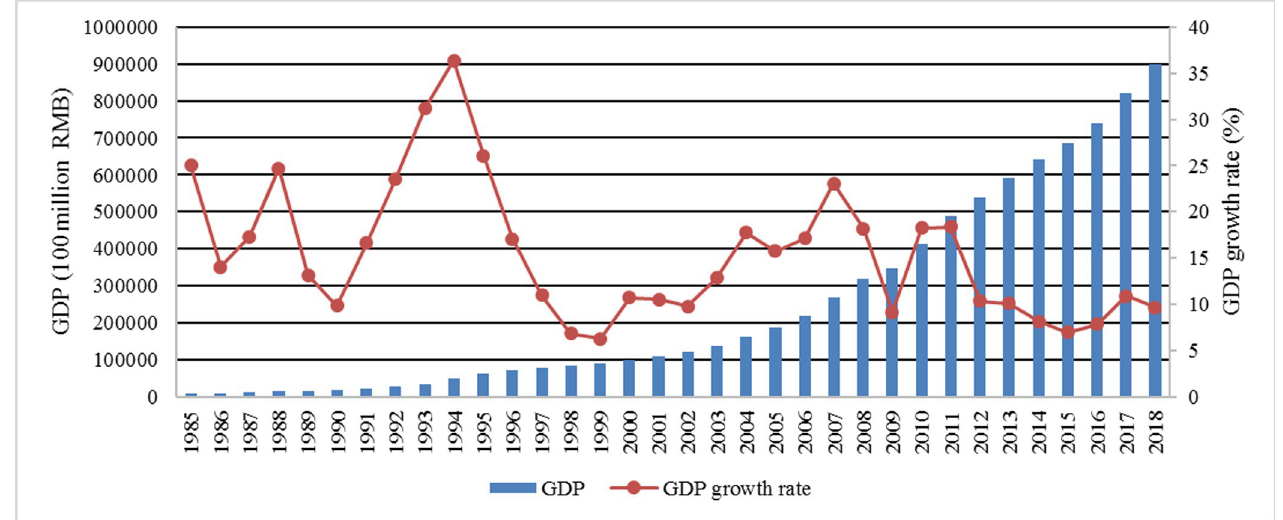
Fig 1. GDP and its growth rate from 1985 to 2018. Data source: China Statistical Yearbook. https://data.stats.gov.cn/search.htm?s=GDP.